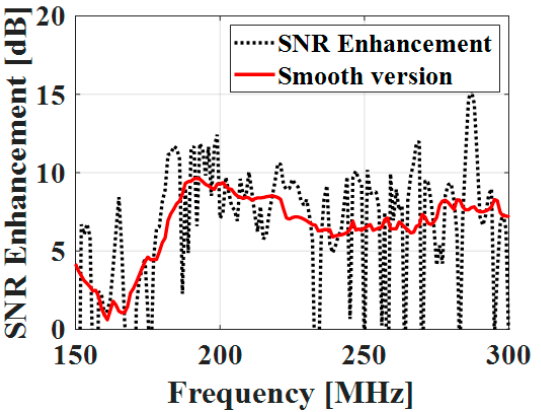
Figure 10. The power measurement data with and without the non-Foster circuit: ( a ) received power and ( b ) noise power.